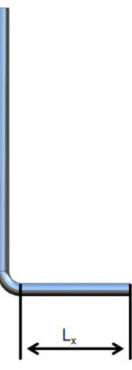
Figure 3. Schematic diagram of L pipe.